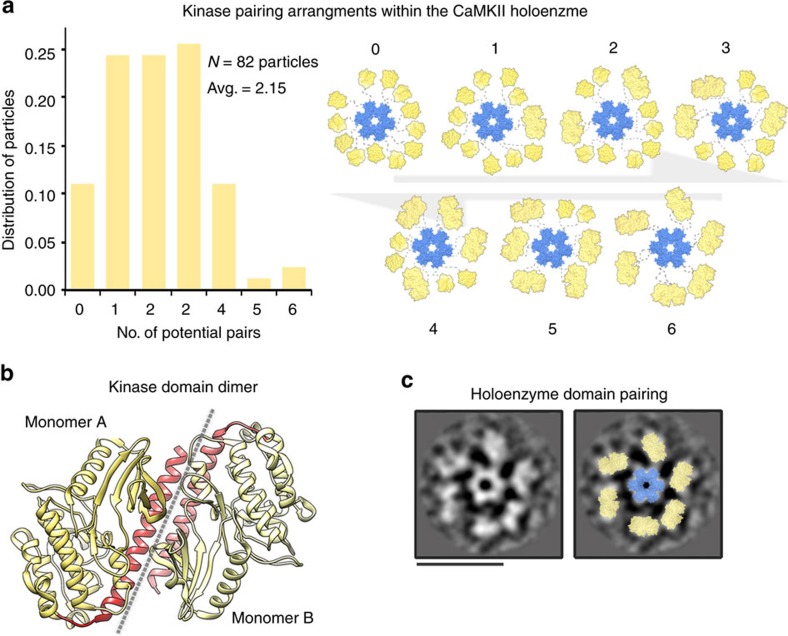
Putative kinase domain pairing in the CaMKIIα holoenzyme observed by single particle EM.(a) Left, Distribution of kinase domain pairing arrangements, based on measured inter-domain distances (as described in main text). Holoenzyme structures were categorized as being arranged with 0–6 kinase domain pairs. Right, Illustration representing holoenzyme structures with various kinase domain pairing arrangements. These structures (and other various arrangements of kinase pairing) are suggested to be in equilibrium with various unpaired kinase arrangements. (b) Crystallographic structure of the C. elegans CaMKIIα kinase/regulatory domain (yellow/red ribbon; PDBID 2BDW (ref. 19)) previously shown to form a dimeric interface involving the regulatory domain (red). (c) Left, Reference-free 2D class average observed for a small population of CaMKIIα particles apparently organized with all kinase domains forming paired interactions. Right, Crystal structures of the hub complex (blue surface) and dimeric kinase domains (yellow surface) are fit into the EM densities. Scale bar=25 nm.